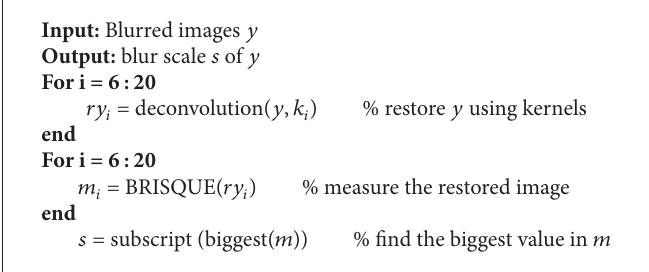
Algorithm 3: Searching